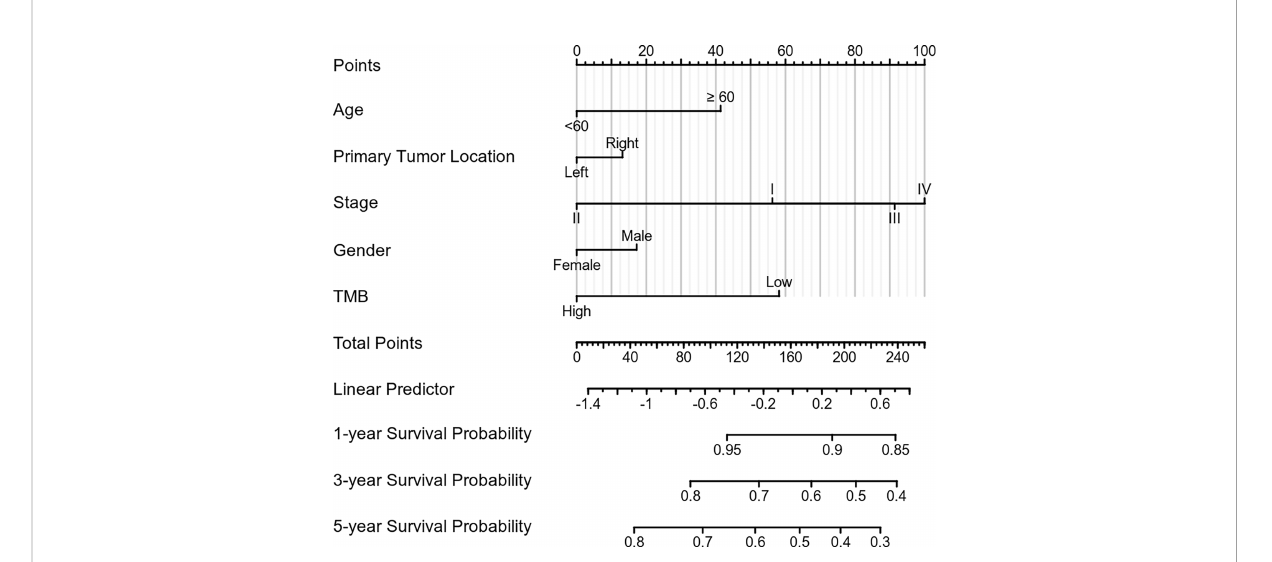
FIGURE 3 Construction of the prognostic nomogram. Predicted 1-, 3-, and 5-year survival rates in colorectal cancer (CRC) patients with KRAS mutations based on our nomogram, which included age, sex, tumor mutation burden, primary tumor location, and stage at diagnosis (C-index = 0.594, 95% CI = 0.566 –